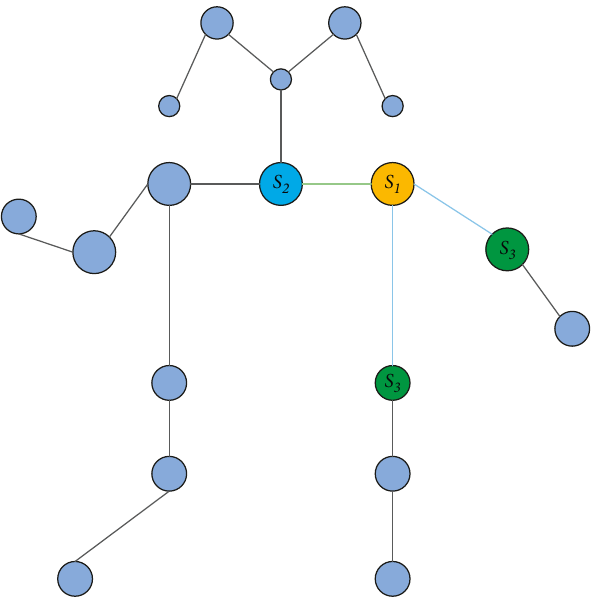
Figure 3: Subset mapping